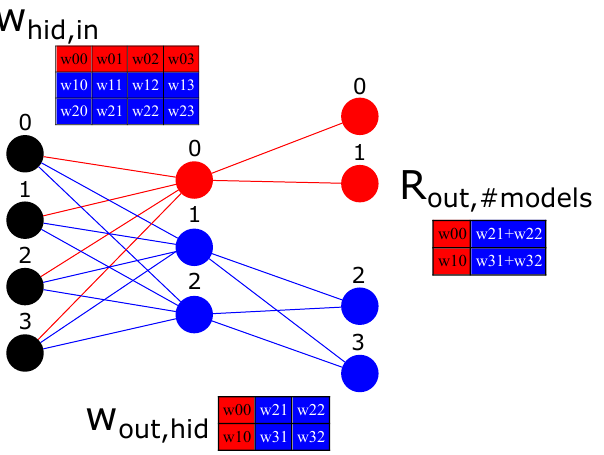
Figure 2. Two independent MLPs are represented as a single MLP with four inputs, 1 and 2 hidden neurons, and two outputs. The weight matrices are also highlighted to understand the parameter mapping from the single MLP architecture to its two internal MLP architectures. The red colour is related to the 4 − 1 − 2 MLP, while the blue colour is related to the 4 − 2 − 2 MLP. R out ,# models contain the result after applying the Scatter Add